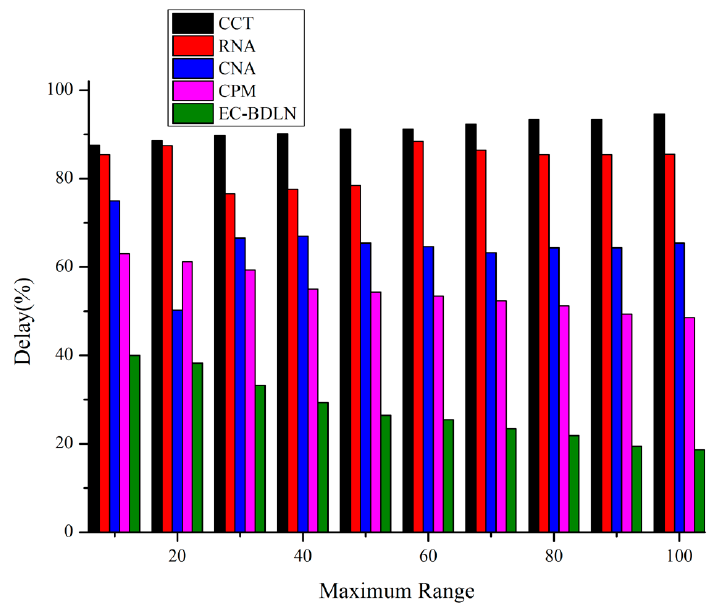
Figure 9. IoT data transmission delay factor of edge computing on Bayesian deep learning network (EC-BDLN).